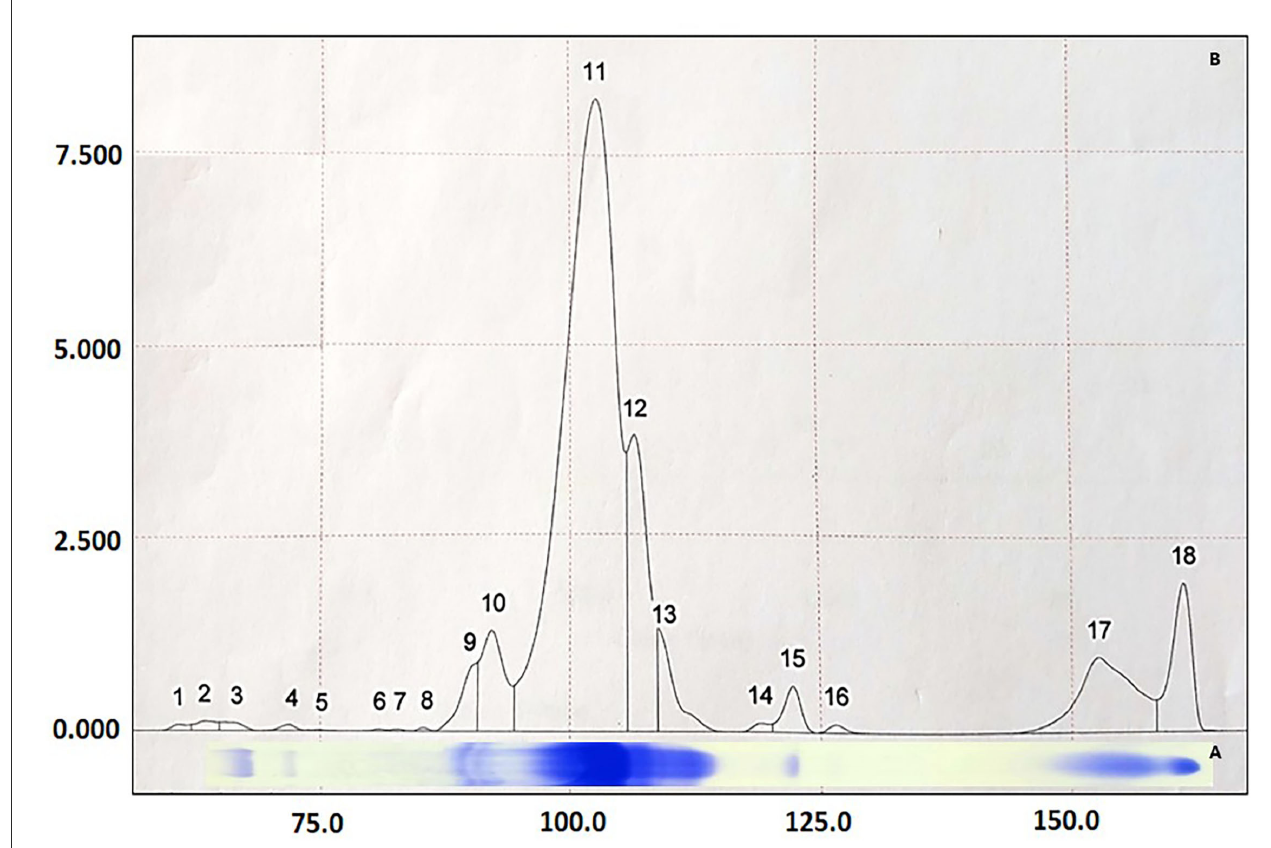
FIGURE1 Graphic representation of proteins identified in equine serum by the SDS-PAGE technique (A) and quantified by densitometry (B) . 18 proteins were found and 8 identified by their molecular weight (kDa): (3) IgA (175 kDa), (4) ceruloplasmin (130 kDa), (9 and 10) transferrin (85 kDa), (11) albumin (65 kDa), (12) α -1-antitrypsin (60 kDa), (13) IgG-HC (55 kDa), (15) haptoglobin (45 kDa) and (17) IgG-LC (29